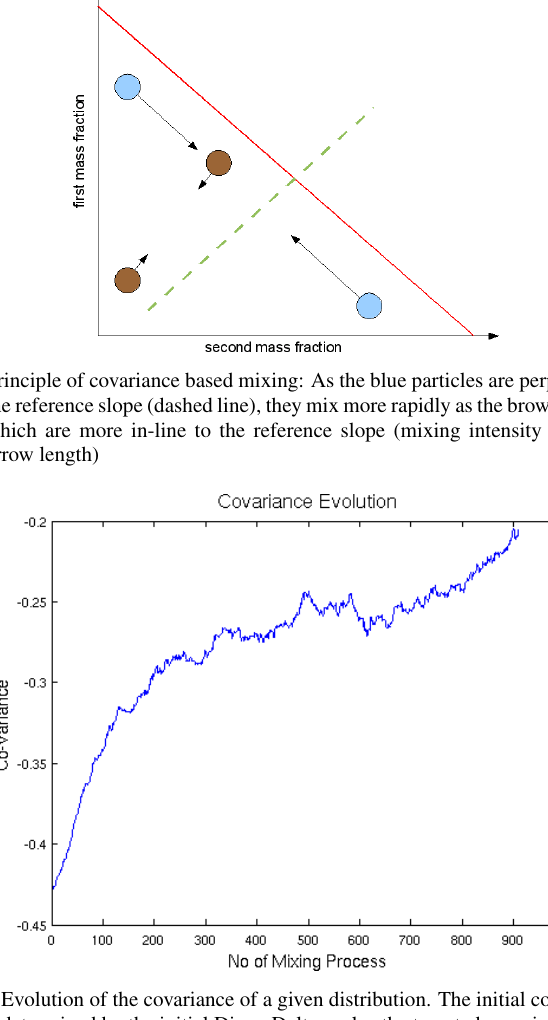
Fig. 5 Evolution of the covariance of a given distribution. The initial covariance is determined by the initial Dirac–Delta peaks, the targeted covariance is